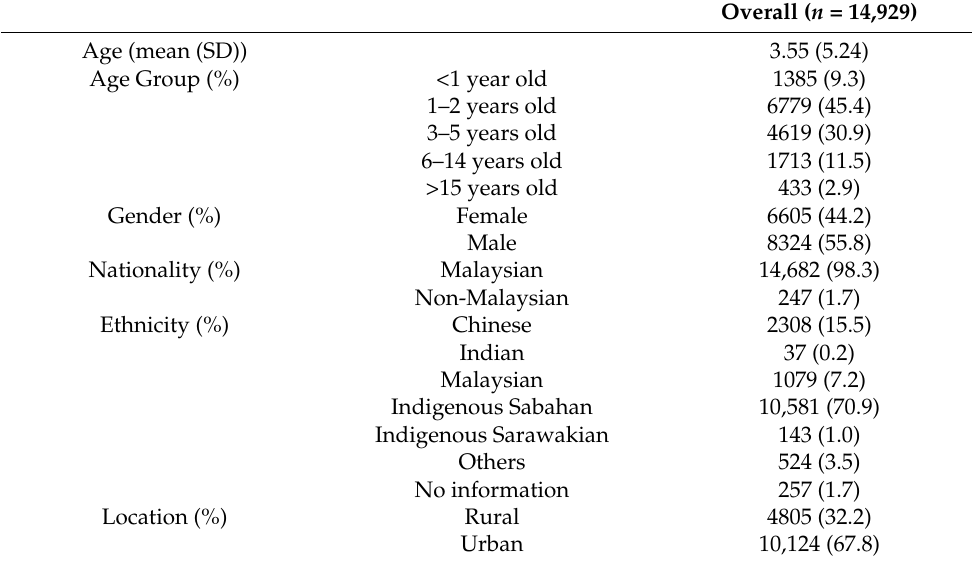
Table 1. Sociodemographic characteristics of HFMD cases in Sabah from